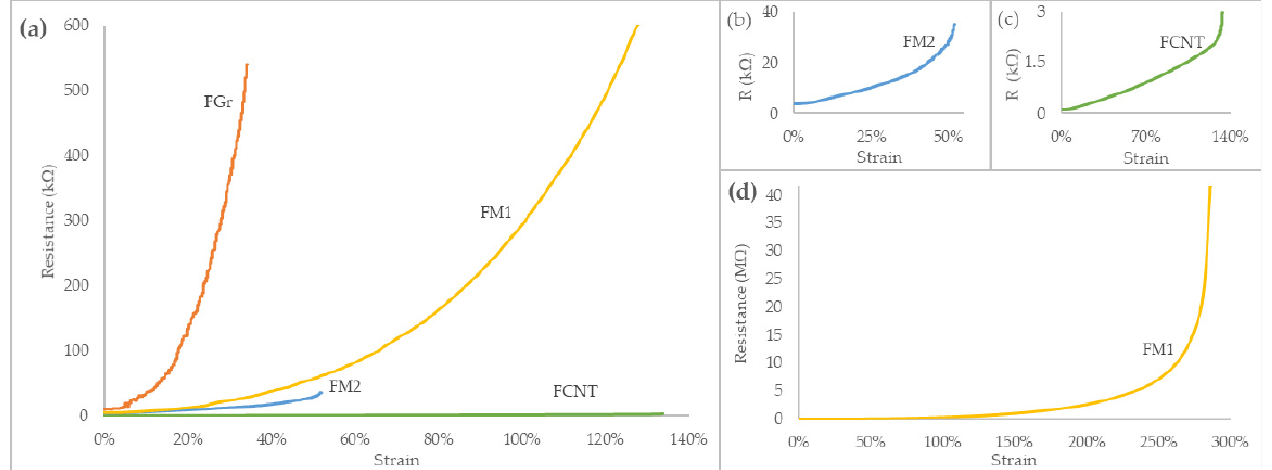
Figure 3. Piezoresistive characteristic of the fibers. ( a ) Resistance curve under strain for 0.5 mm fibers FGr, FCNT, FM1, and FM2; ( b – d ) R/ ε plots for individual FM2, FCNT, and FM1 fibers.